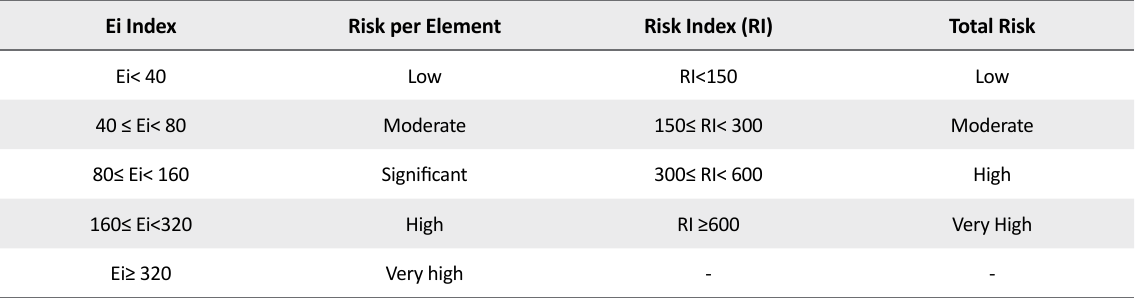
Table 4. Characteristic values of potential ecological